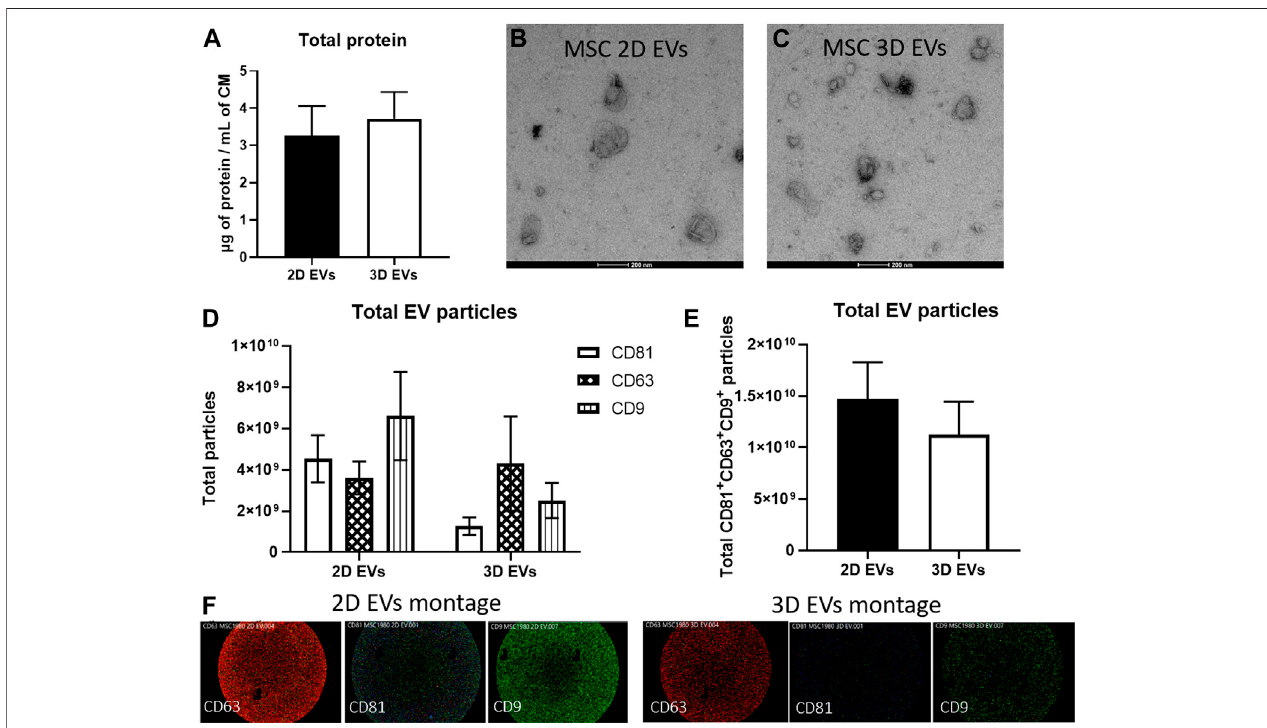
FIGURE 2 | Characterization of EVs produced by MSCs in 2D and 3D spheroid culture. (A) BCA assay to determine total protein yield. (B – C) Negative staining imagesofMSC2Dand 3DEVsontransmissionelectron microscope.Scalebar=200 µm (D) EV particleanalysisandphenotypingforindividualEVtetraspaninmarkers CD63, CD81, and CD9 expressions using SP-IRIS. (E) Total CD63 + CD81 + CD9 + particles from each sample, n = 3 each. (F) Visualisation of multi-colour fl uorescence signalsobtainedfromSP-IRISimagingwhichrepresentssinglevesicleevents.DetectionperformedwithCD81-AF555(green),CD63-AF647(red),andCD9-AF488